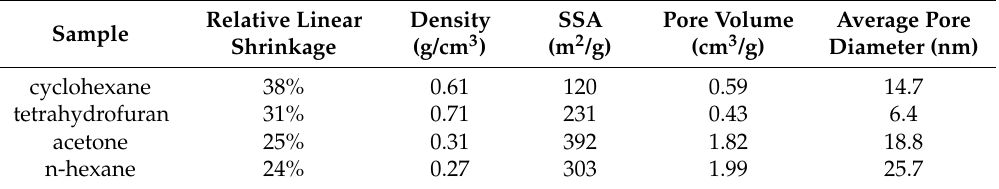
Figure 1. Polymeric poly(methylhydrosiloxane)/divinylbenzene (PMHS/DVB) aerogels synthesized in n-hexane after supercritical drying. Table 1. Linear shrinkage (relative change of linear dimensions), density, BET specific surface area (SSA), pore volume, and average pore diameter of polymer aerogels synthesized in cyclohexane, tetrahydrofuran (THF), acetone, and